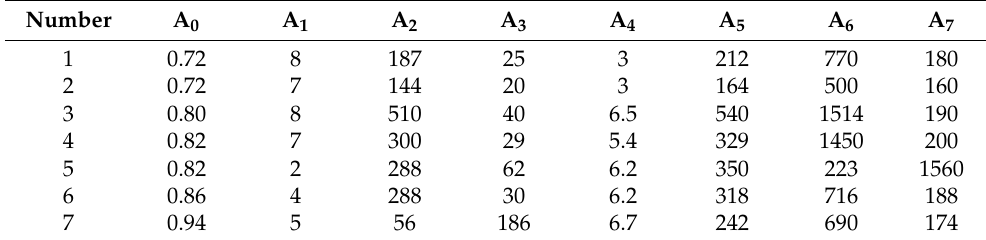
Table 2. Data on factors influencing surface subsidence in Lu’an mining area.